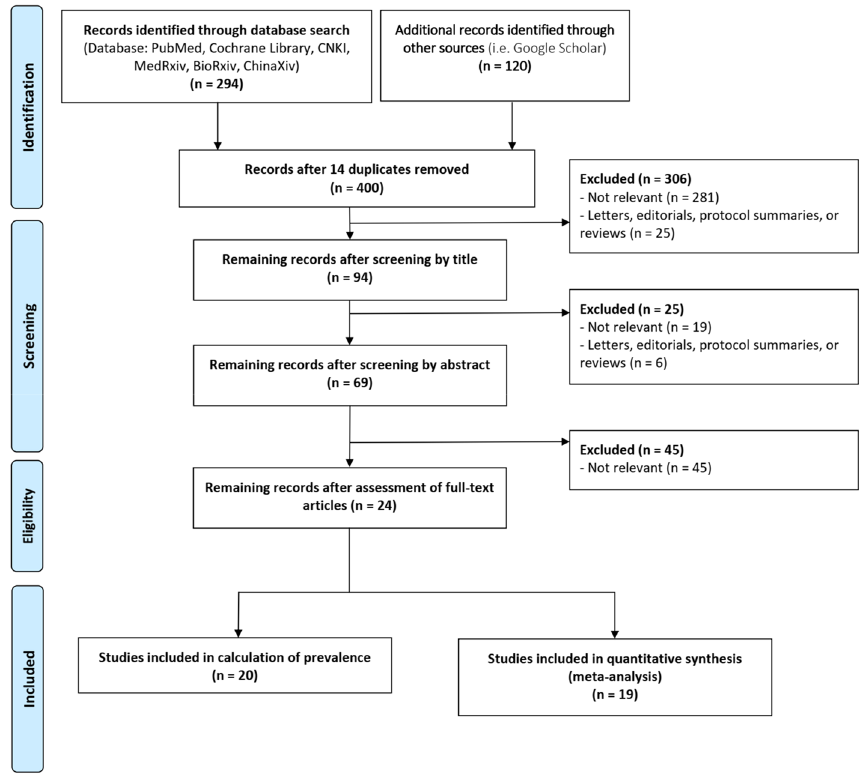
Figure 1. Preferred Reporting Items for Systematic Reviews and Meta-Analyses (PRISMA) flow diagram of this study, showing the studies included in pooled prevalence calculation and quantitative